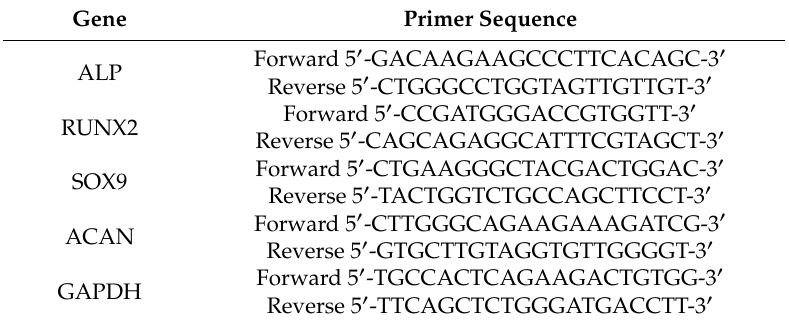
Table 1. Sequences of primers used for gene expression analysis by